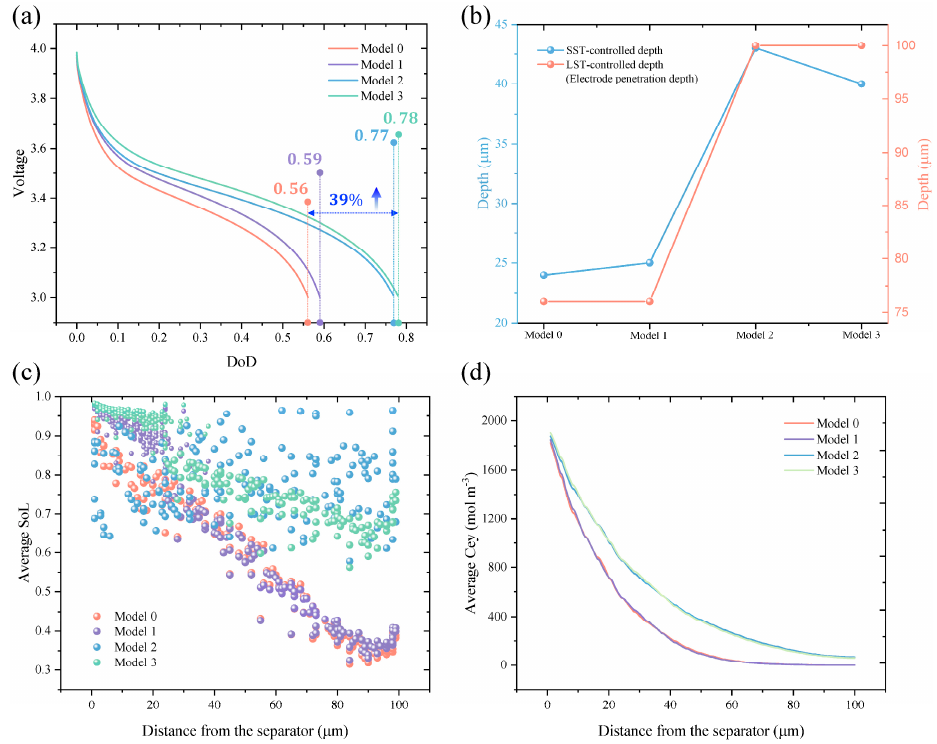
Figure 5. Comparison of ( a ) voltage response; ( b ) the SST-controlled depth, and the LST-controlled depth (penetration depth) for di ff erent microstructural designs; ( c ) average SoL; and ( d ) lithium ions concentration pro fi les in the electrolyte at the end stage of discharge.